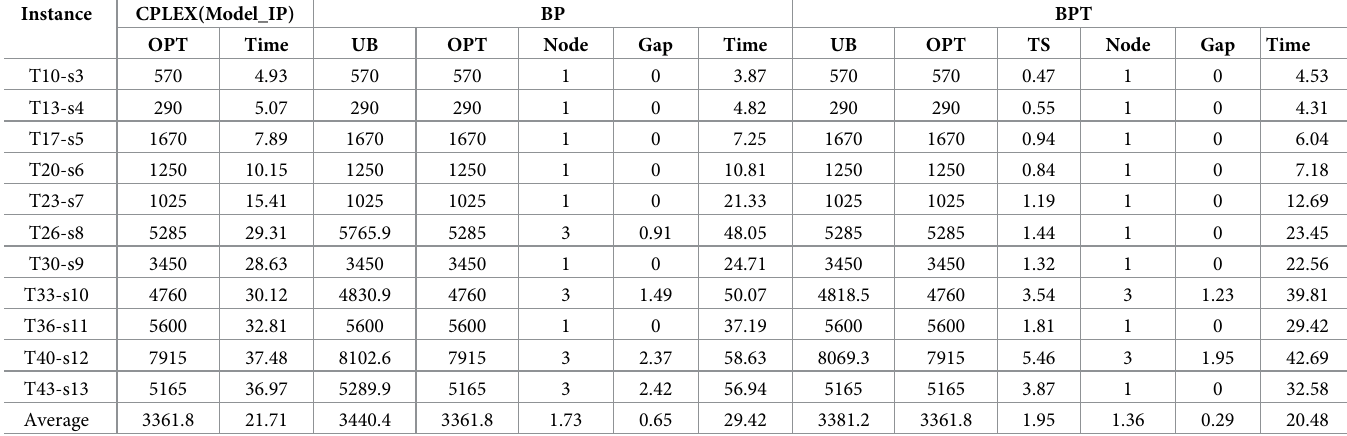
Table 9. The impact of increasing shift working